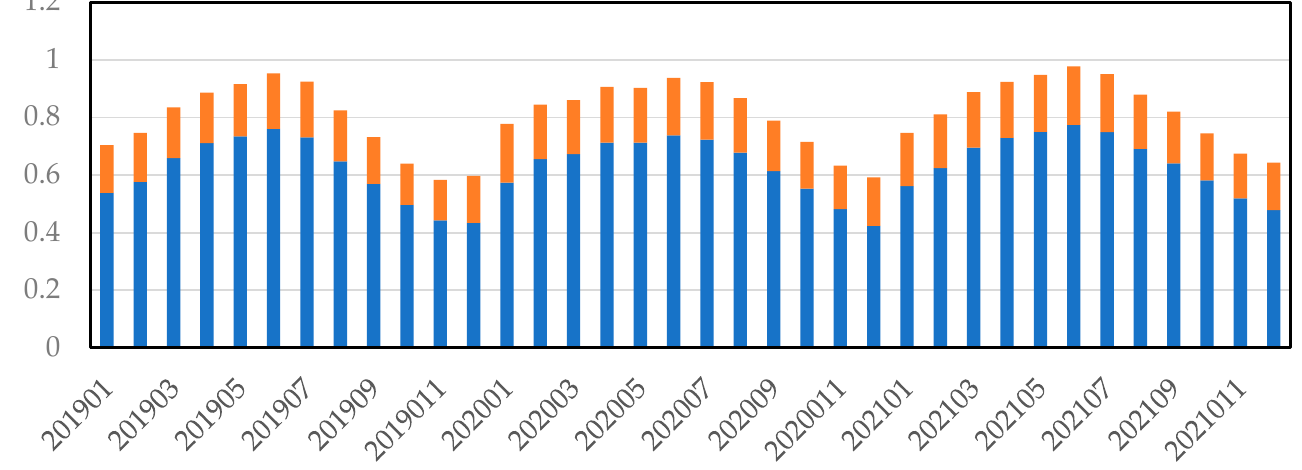
Figure 4. Monthly median and standard deviation of NDVI from 2019 to 2021.